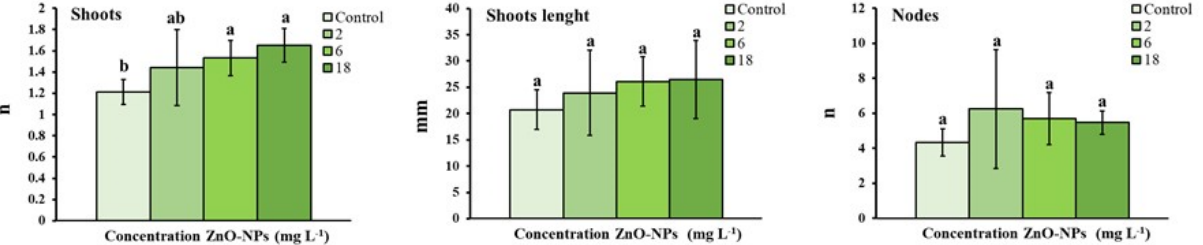
Figure 1. Shoots number, shoots length and, number of nodes values ± SD of the olive proliferated explants. Means values followed by different letters were significantly different ( p < 0.05).